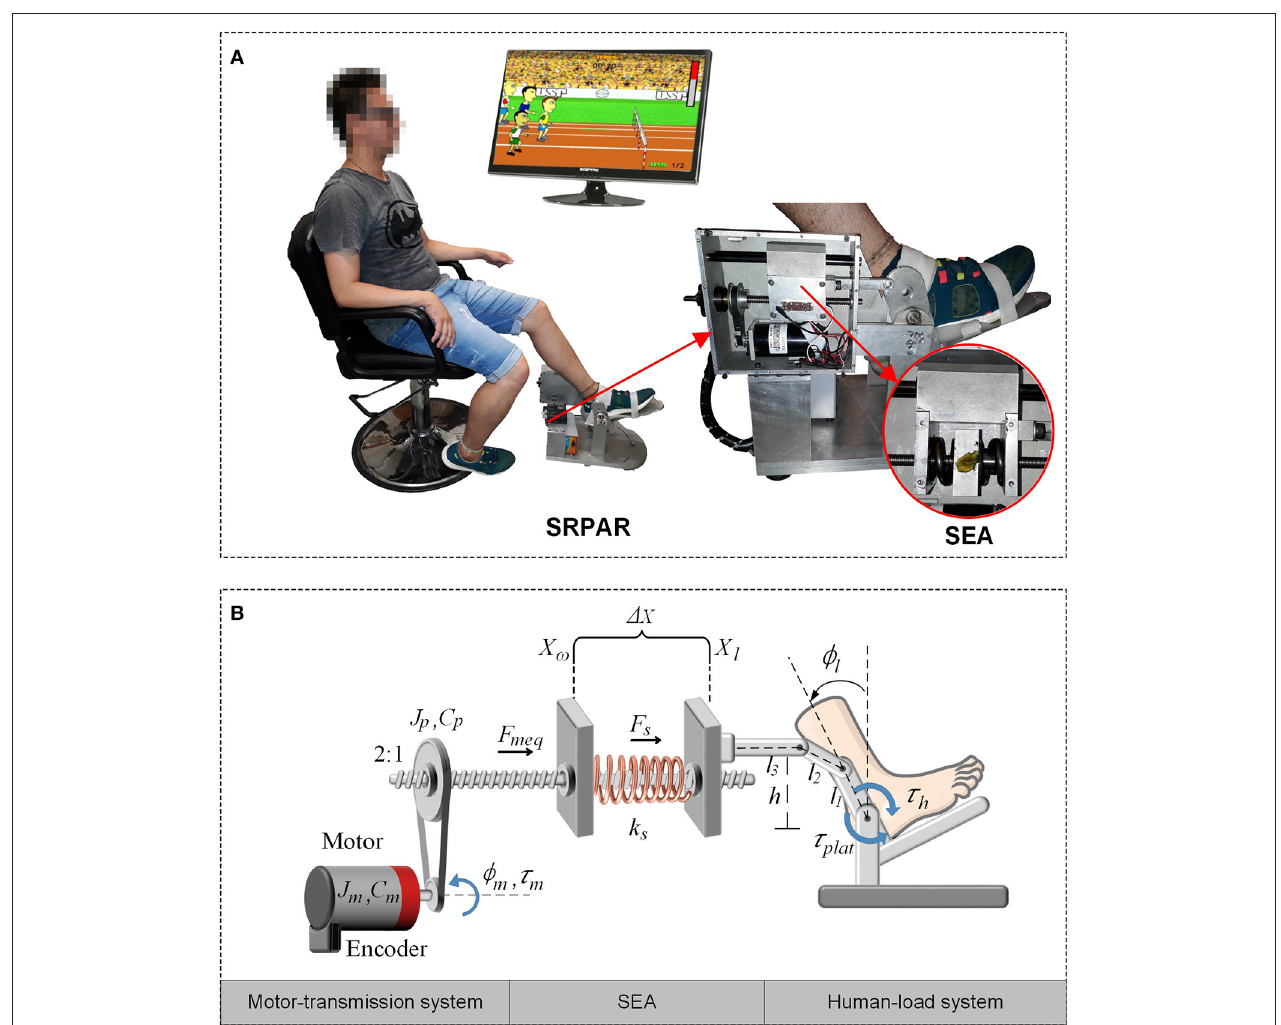
FIGURE 1 | SEA-based Robotic Platform for Ankle Rehabilitation (SRPAR). (A) Platform (Gonçalves et al., 2014). (B) Squematic